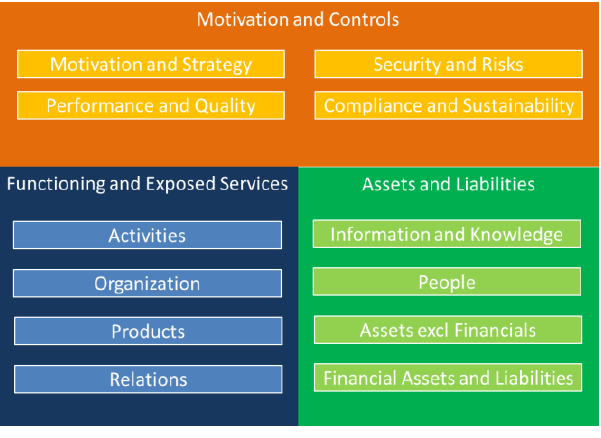
Figure 2 . Domain segregation of holistic architecture of an enterprise [13]